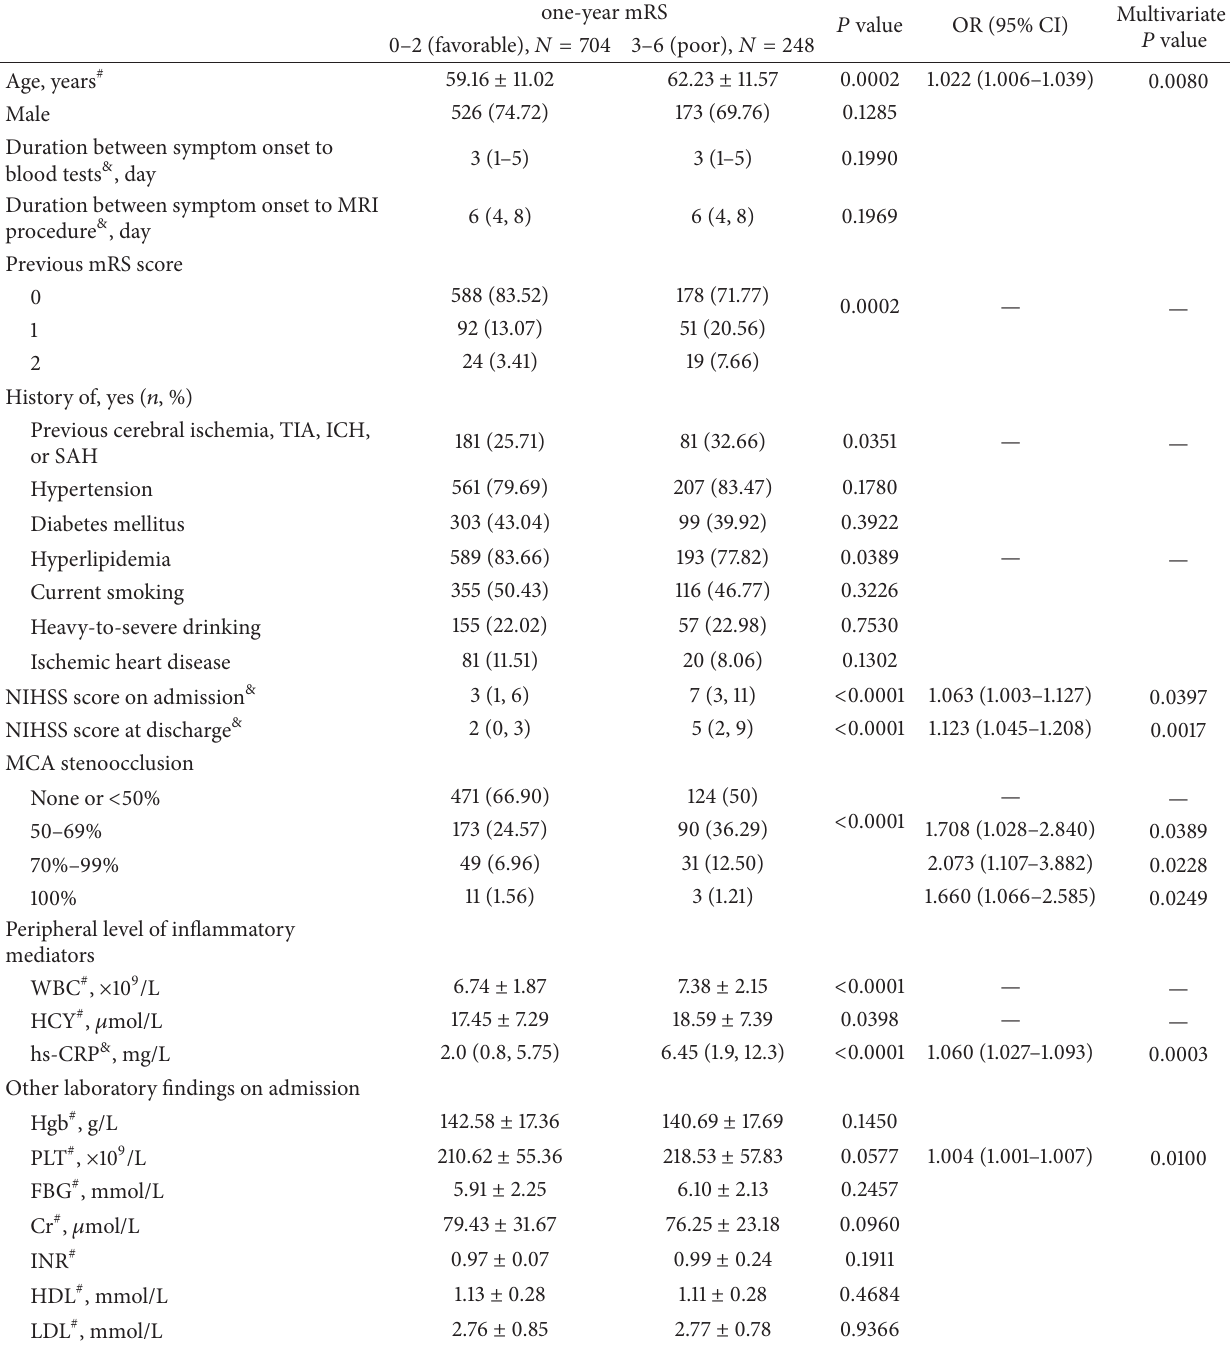
Table 3: Univariate and multivariate analysis in patients’ 1-year